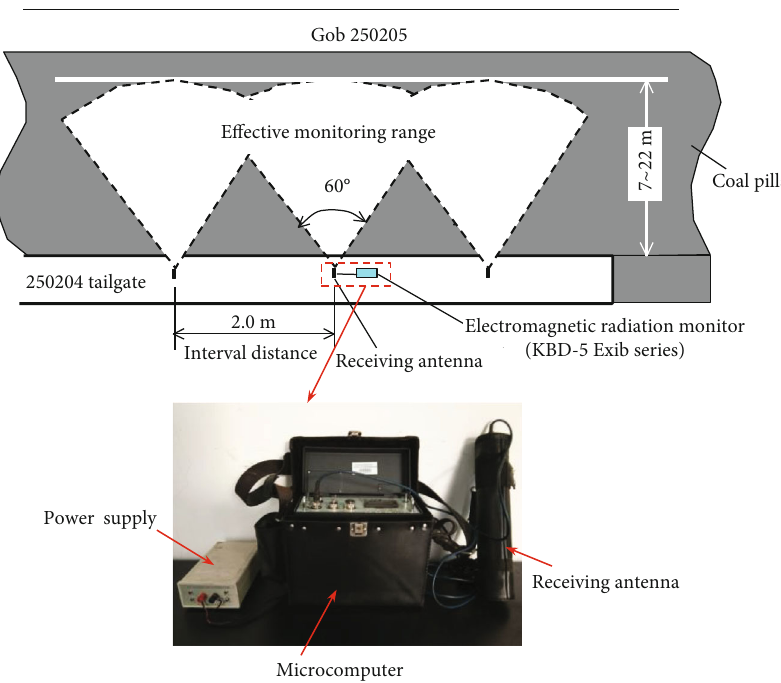
Figure 17: The monitoring diagram of coal-pillar side in the 250204